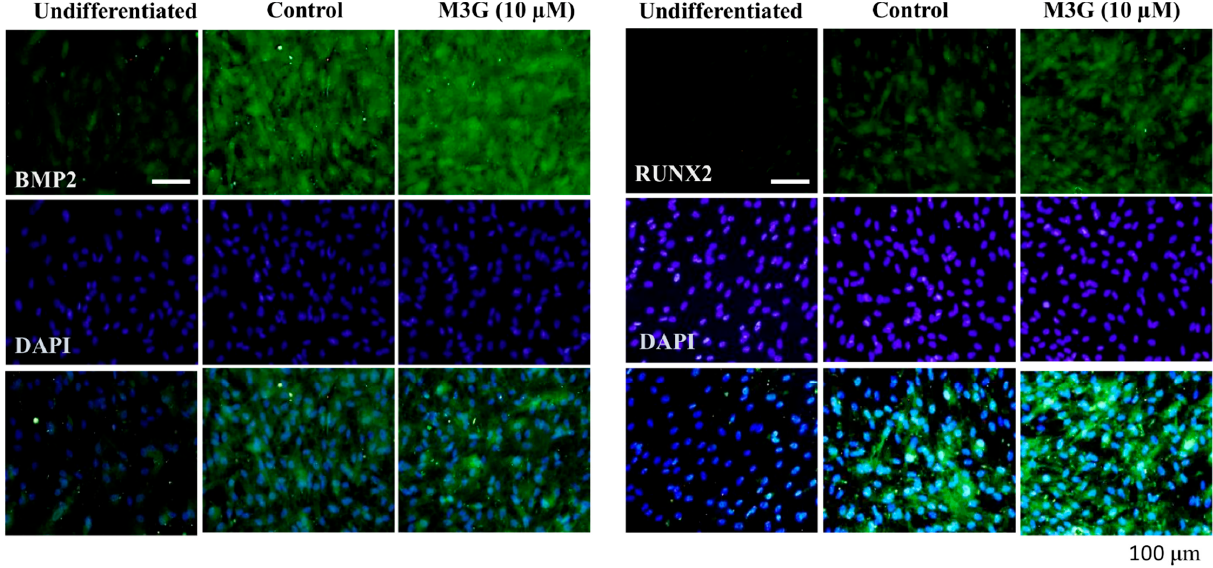
Figure 5. Effect of M3G on osteoblastogenesis marker protein expression. Analysis of protein expression was carried out by immunofluorescence staining of osteo-induced hBM-MSCs at day 10 differentiation. M3G was treated with initial differentiation induction (3 days) and M3G was not present in subsequent media changes. β -actin was used as internal loading control. Scale bar: 100 μ m.